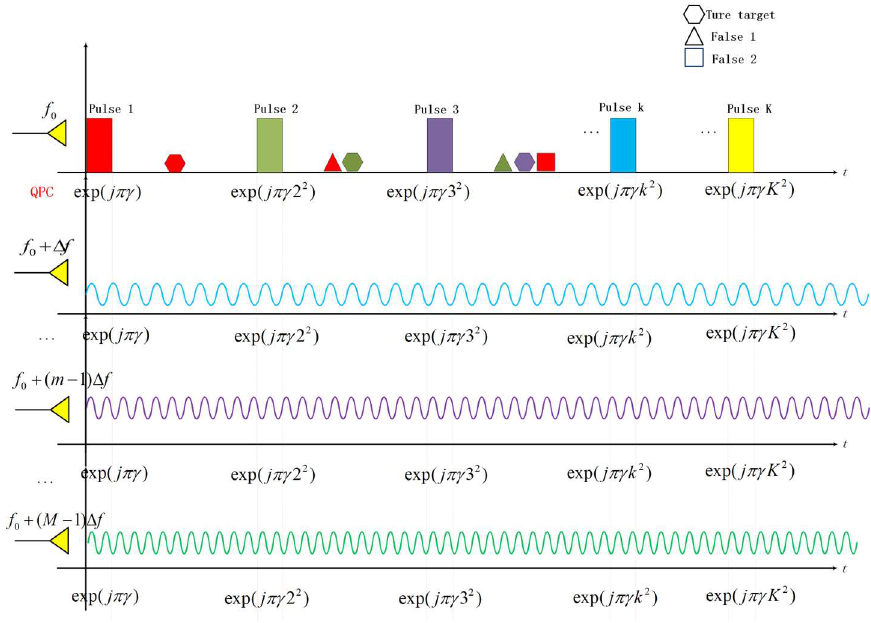
Figure 2. Illumination of true and false targets with QPC-FDA-MIMO.